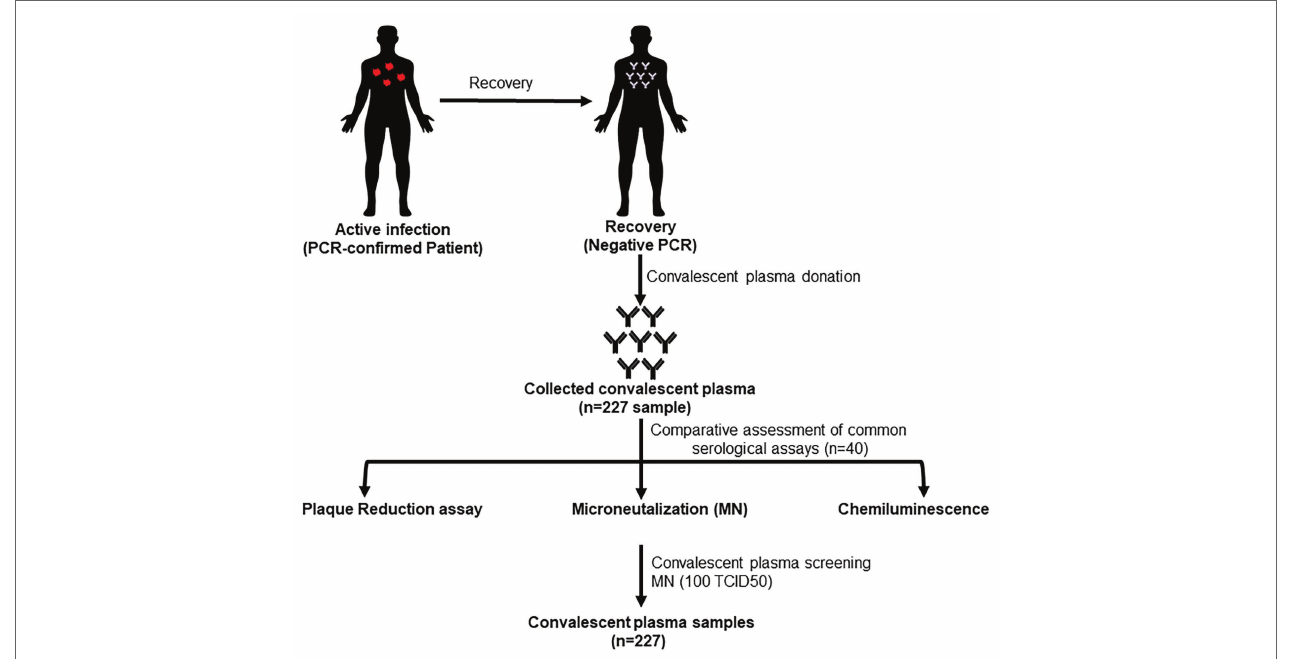
FIGURE 1 | Scheme showing convalescent plasma donors who were involved in the